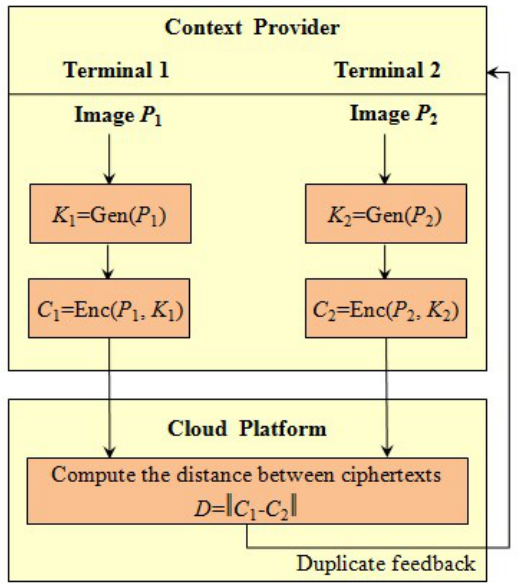
Figure 1. The mechanism of private-preserving file-level deduplication system based on the convergent